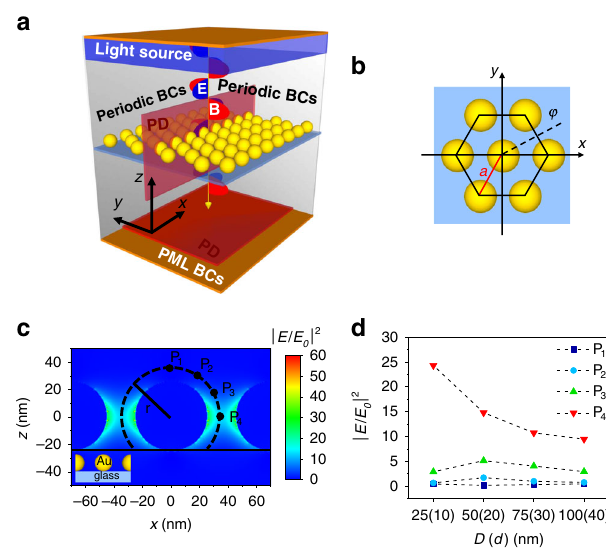
Fig. 2 Optical properties of 2D AuNP lattice. a Schematic representation of the simulation workspace consisting of plane wave source, plasmonic nanostructure, dielectric substrate (SiO 2 glass), photodetectors and appropriate BCs. Linearly x -polarized EM wave propagates through the 2D AuNP lattice. The transmitted photons are collected by a PD on the opposite side of the workspace, whereas the E- fi eld intensity distribution is worked out by placing several PDs in correspondence of the lattice (not all depicted in the sketch). b Top view sketch of the simulation unit cell; the centers of the spherical AuNPs belong to the plane z = 0. The parameters a and φ are the lattice constant and the azimuthal angle, respectively. c Example of E- fi eld distribution normalized to the incident radiation worked out in the plane y = 0 for x -polarized EM plane wave incident on a lattice made of AuNPs with diameter 50 nm and interparticle distance 20 nm. The points P 1 – P 4 are at a distance of 10 nm from the nanoparticle surface at polar angle θ = 0°, 30°, 60°, and 90°, respectively. d Gain of the E- fi eld intensity as a function of AuNP diameter (interparticle